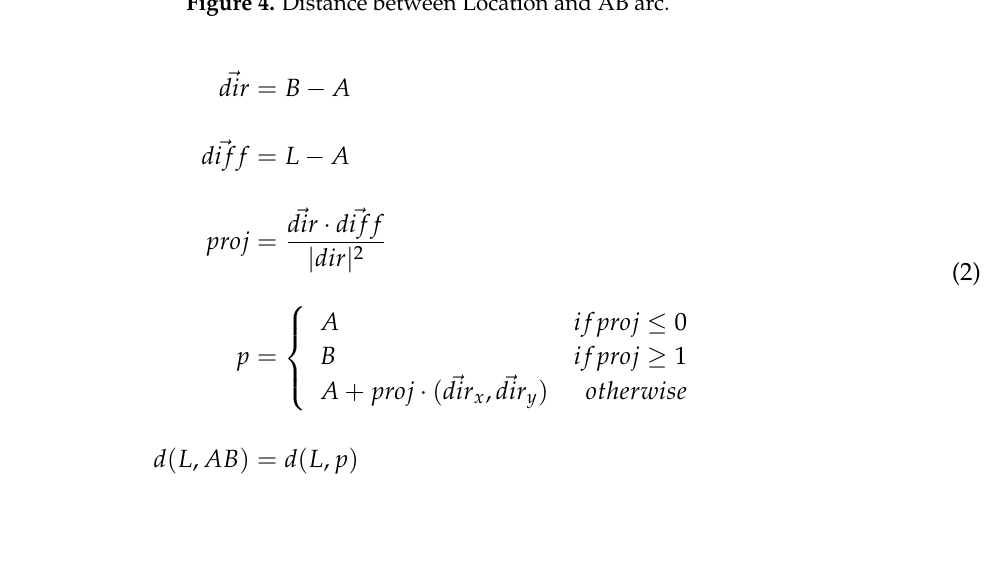
Figure 4. Distance between Location and AB